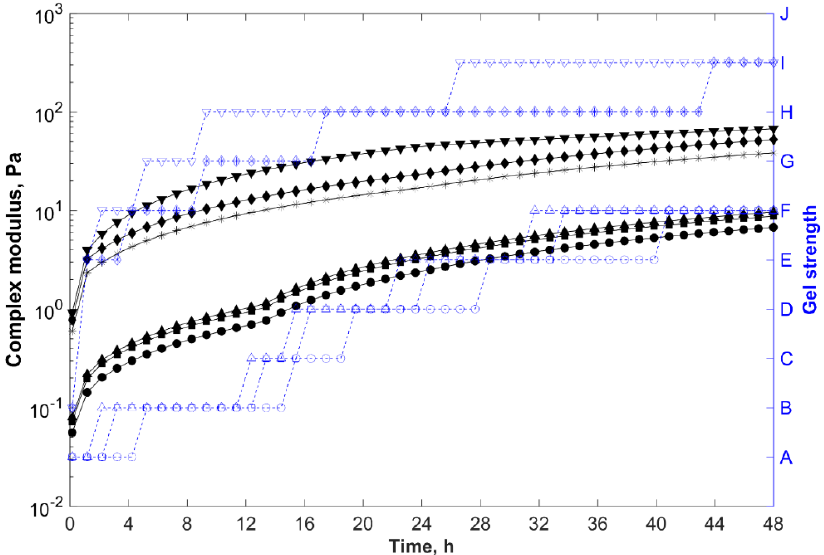
Figure 6. Complex modulus ( ─ ) and gel strength (- -) versus time for samples prepared in distilled or field water at 85 °C, with 0.6 wt % polymer, 0.5 wt % PEI, and 0.8 wt % clay of different types (F4).